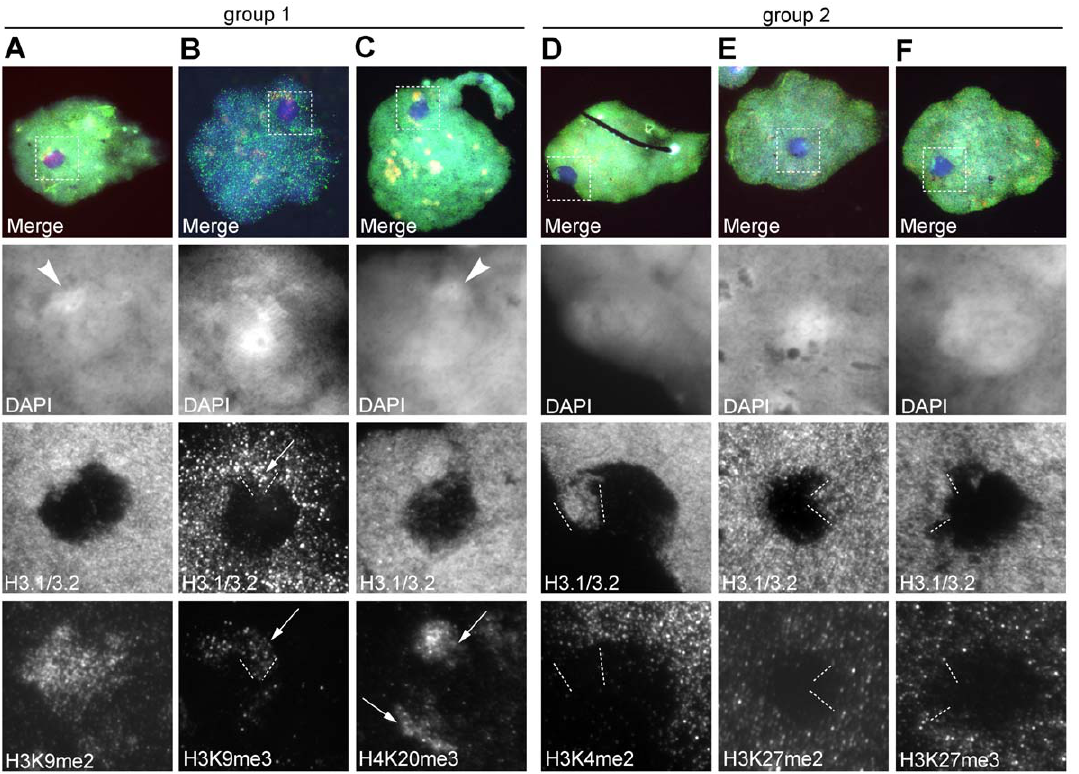
Figure 8. Histone characteristics of the XY body. A–F Late pachytene nuclei are shown with a mid-2 to high degree of H3.1/3.2 nucleosome eviction. In the merge panel DAPI, H3.1/3.2 and the PTM are depicted. A H3K9me2 was strongly present on XY chromatin including Yqh, as indicated by the brighter DAPI domain (arrowhead). B H3K9me3 was present on the Yqh H3.1/3.2 bulge (arrow) and irregular on other XY chromatin. C Two H4K20me3 stained domains were found in and associated with X,Y chromatin and were co-staining with H3.1/3.2. Part of the upper domain was located in brighter DAPI XY body chromatin (arrowhead) reminiscent to Yqh. D–F H3K4me2, H3K27me2 and H3K27me3 were strongly decreased in X,Y chromatin, including Yqh as indicated by the dotted lines.